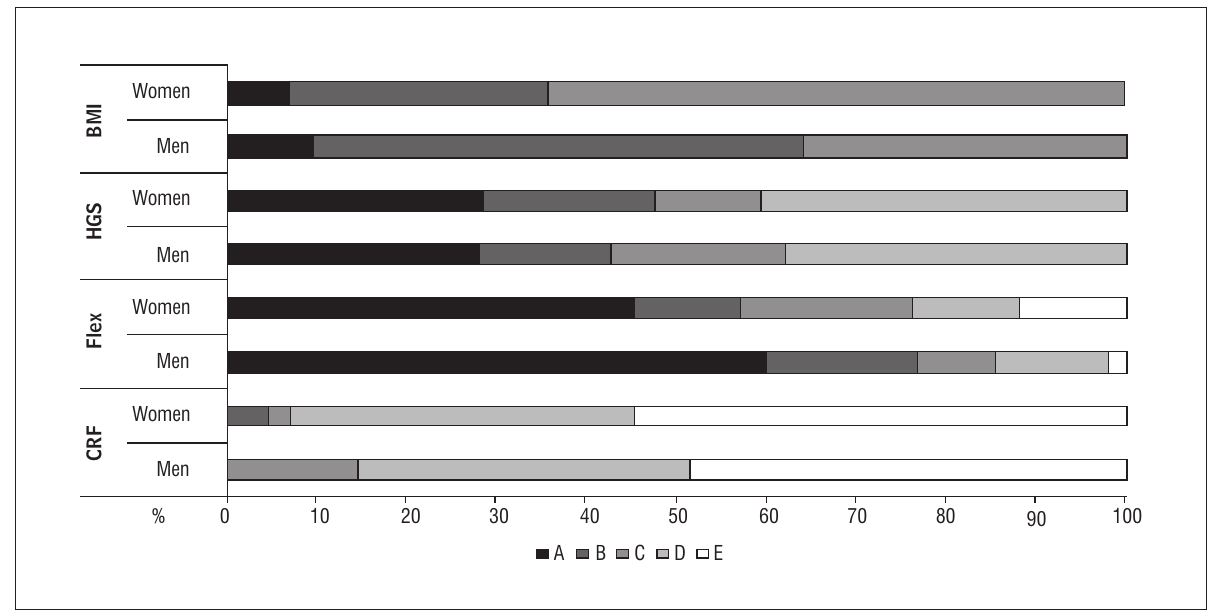
Figure 1 – Classification of physical fitness components according to sex